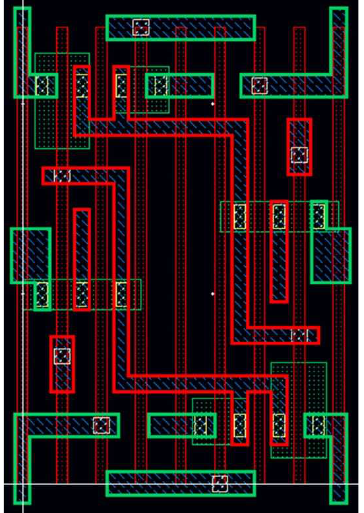
Figure 3. Layout of the 8-T hardened